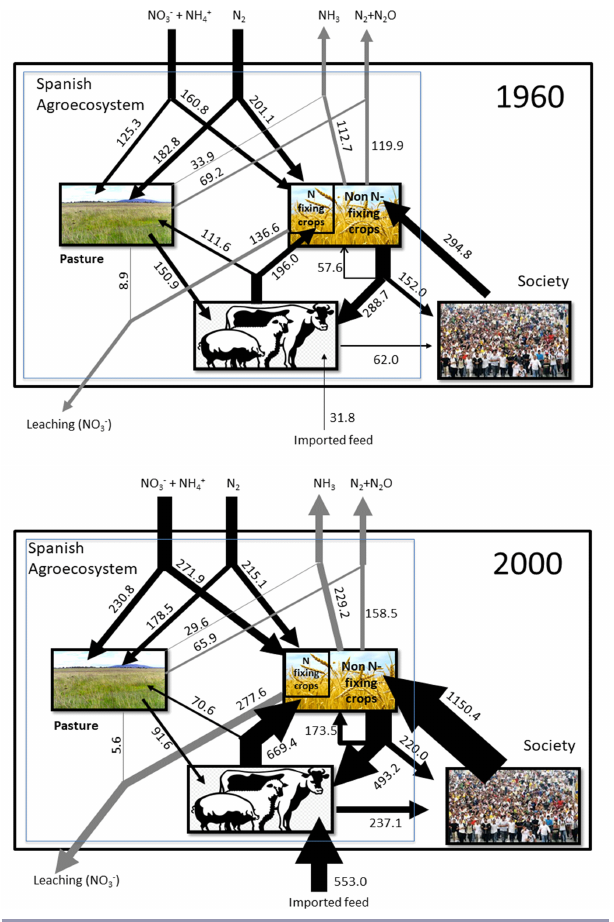
Fig. 3 . Nitrogen flows (Gg) in Spanish agroecosystem in 1960 and